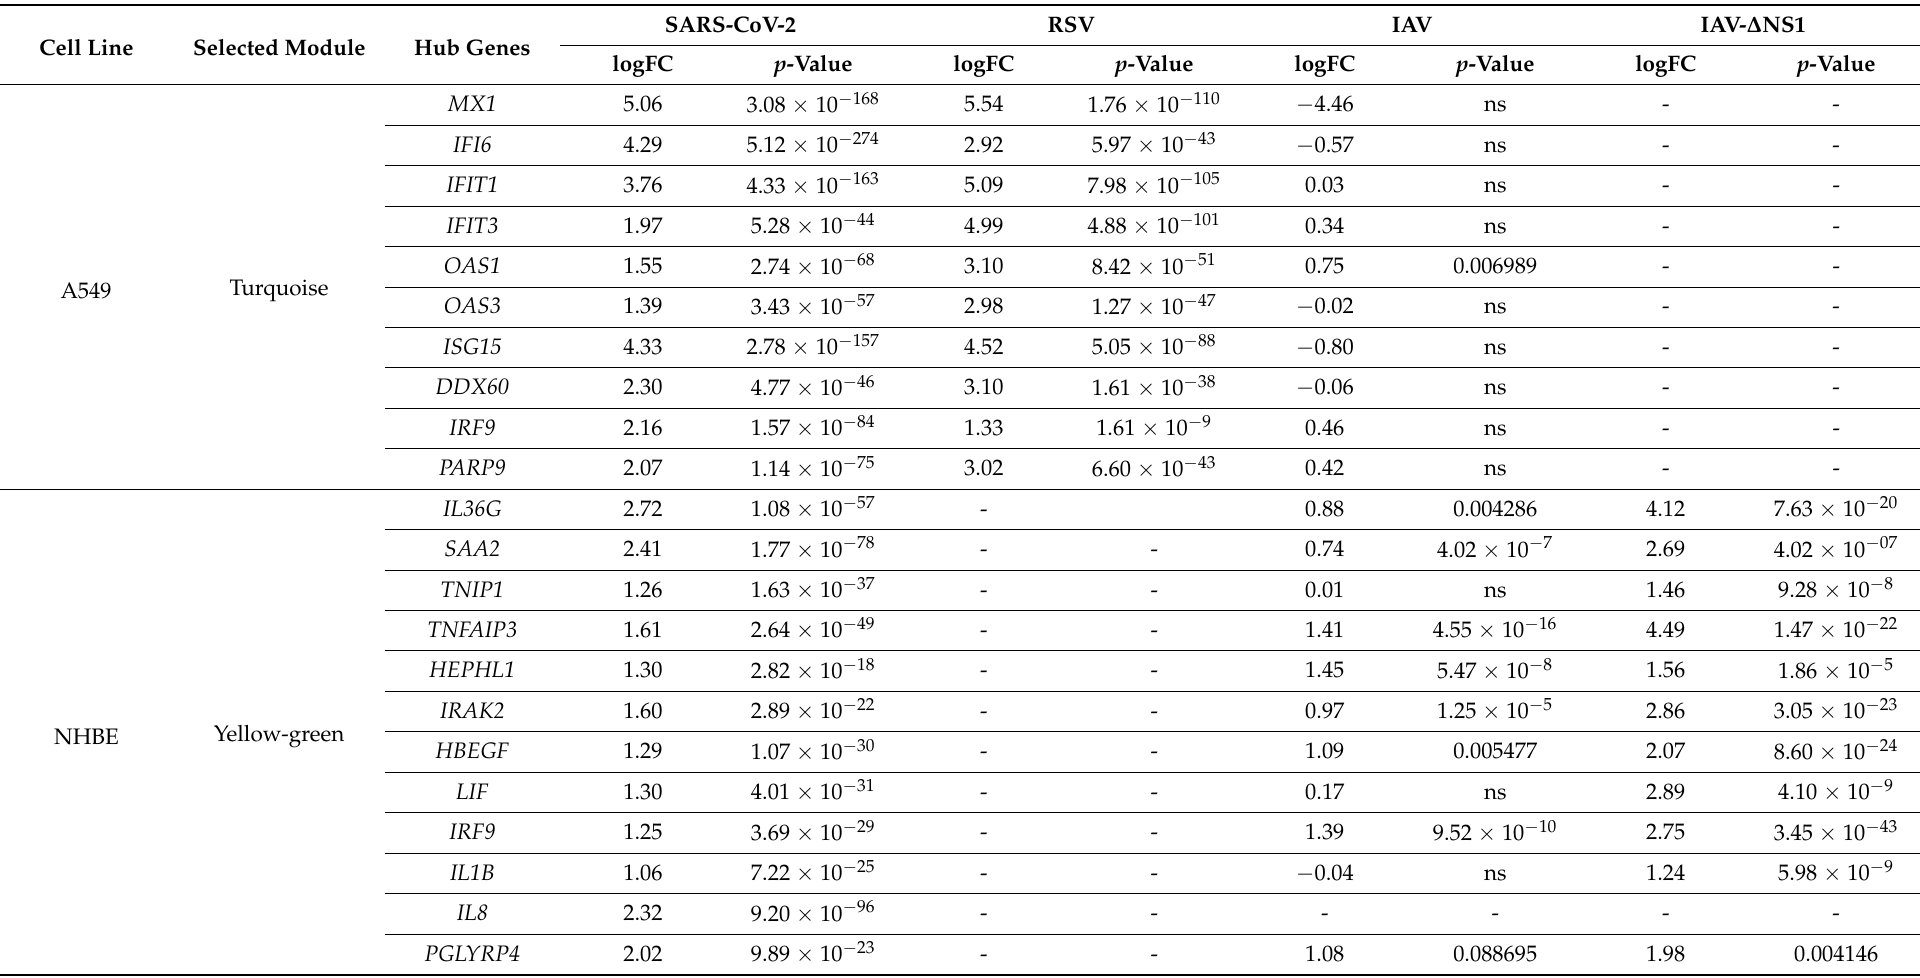
Table 1. Comparison of hub gene expression profiles of interesting modules in the response of SARS-CoV-2, RSV, IAV, and IAV- ∆ NS1. Cell Line Selected Module